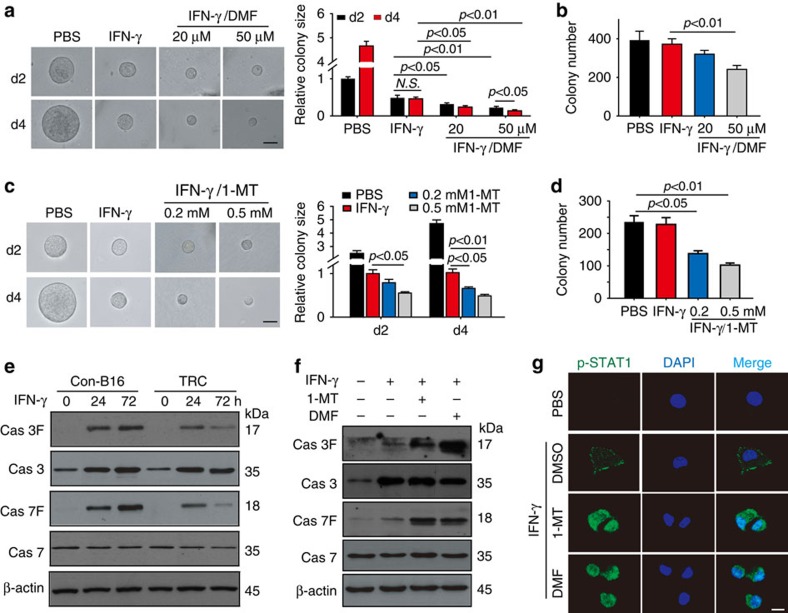
Switching IFN-γ-mediated IDO-Kyn-AhR cascade to STAT1 signalling targets TRC dormancy.(a,b) B16 cells (1.25 × 103) were seeded in soft 3D fibrin gels. Two days later, IFN-γ was added for further 2 days (d2) or 4 days (d4) culture in the presence or absence of different concentration of DMF. The colony size was presented (a) and colony number was counted (b). The relative colony size was calculated by comparing the colony size in other groups with the colony size in the PBS (d2) group, which was set to 1. The data represent mean±s.e.m. (n=3). Bar, 50 μm. (c,d) The above B16 TRCs were cultured in the presence or absence of different concentration of 1-MT. The colony size was presented (c) and colony number was counted (d). The relative colony size was calculated by comparing the colony size in other groups with the colony size in the PBS (d2) group, which was set to 1. The data represent mean±s.e.m. (n=3). Bar, 50 μm. (e) control B16 cells or B16 TRCs were treated with 100 ng ml−1 IFN-γ for 24 or 72 h (n=3). Caspase 3 (Cas 3), caspase 7 (Cas 7) and their cleaved forms (Cas 3F and Cas 7F) were determined by western blot. (f) B16-TRCs were treated with IFN-γ (100 ng ml−1) plus 1-MT (0.2 mM) or DMF (20 μM) for 72 h (n=3). Caspases were analysed by western blot. (g) B16-TRCs were treated with IFN-γ (100 ng ml−1), IFN-γ/1-MT (0.2 mM) or IFN-γ/DMF (20 μM) for 72 h. Immunostaining of p-STAT1 (green) and DAPI (blue) was shown as the representative of three independent experiments. Bar, 10 μm.